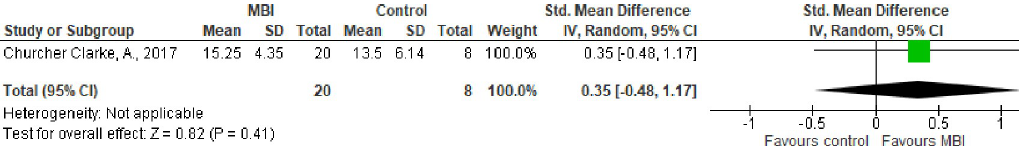
Fig 7. Forest plot of comparison: Cognitive function, MBI versus control after 6 to 10 weeks from the beginning of the intervention.